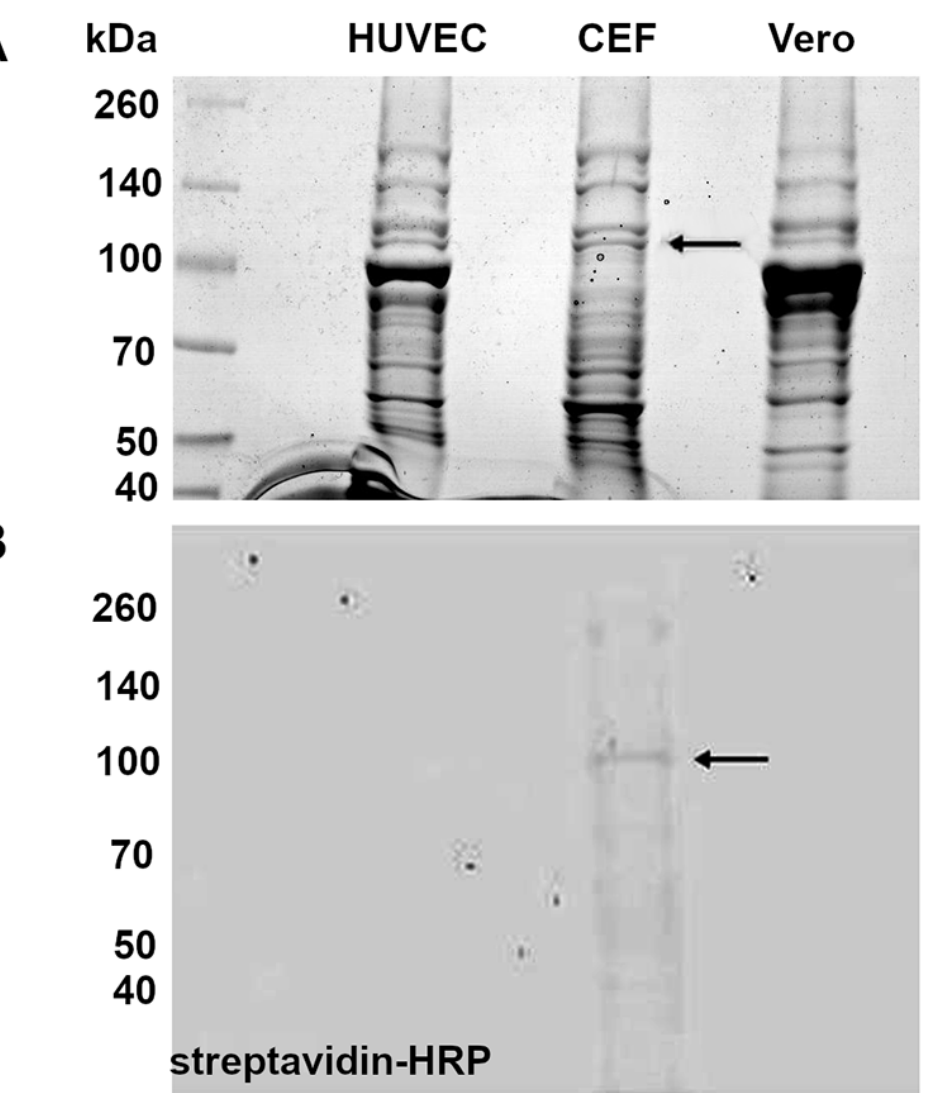
Figure 6. Detection of avian proteins, possibly involved in the effects of ECVF on cells. (A) SDS-PAGE showing the proteins extracted from HUVEC, CEF and Vero cells. (B) ECVF-biotin incubated membrane was revealed using peroxidase-conjugated streptavidin. Arrow indicates the CEF’s proteins band for which interaction with ECVF was